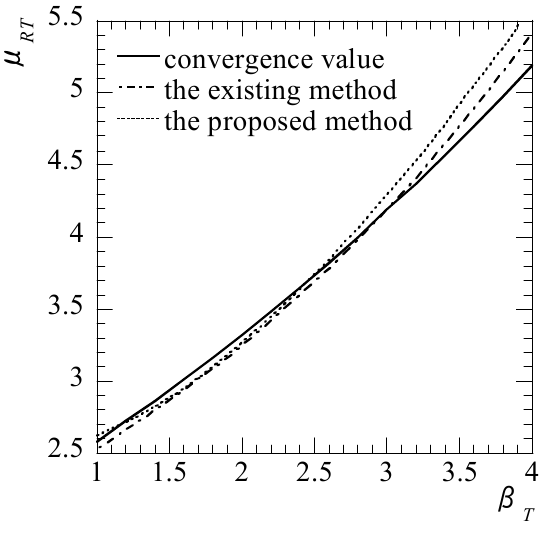
Figure 2. Target mean resistance.